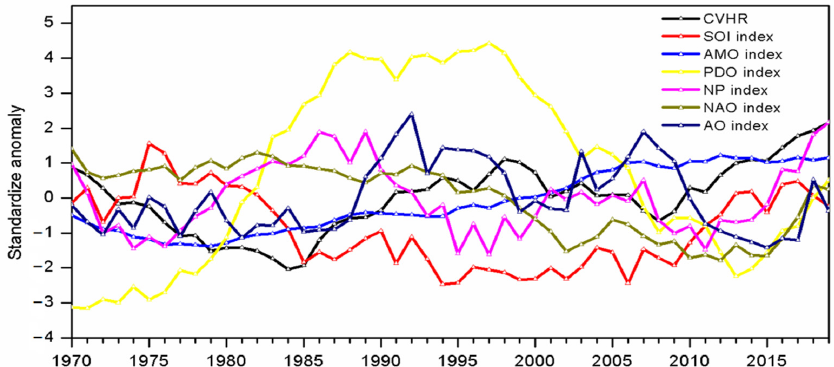
Figure 10. Interdecadal variability in the 10-year running mean NECVHR anomaly based on the standard deviation, southern oscillation index (SOI), Atlantic multidecadal oscillation (AMO), Arctic oscillation index (AO), North Pacific index (NP), North Atlantic oscillation (NAO), and Pacific decadal oscillation (PDO). Interdecadal component of correlation coefficients between various indices and NECVHR as shown in Table